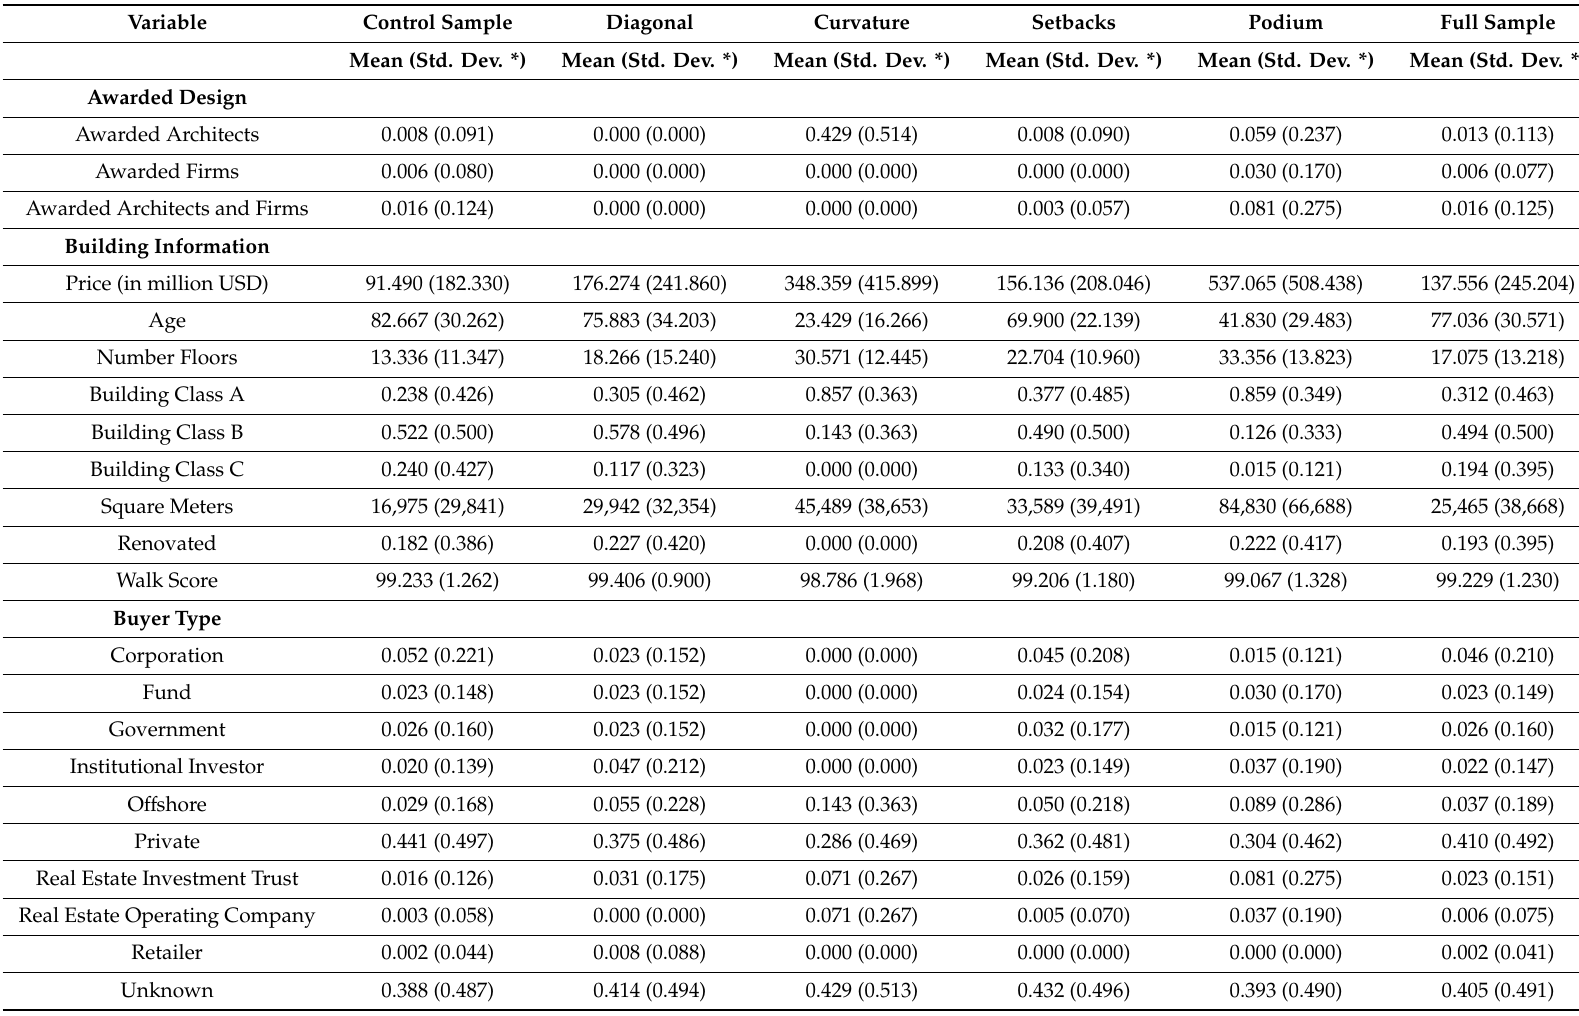
Table 1. Descriptive statistics of building characteristics and transaction details by geometry. Table 1 highlights the mean and variation of building characteristics for the building samples with curvature, site location on a diagonal intersection, podium, and the New York City setback